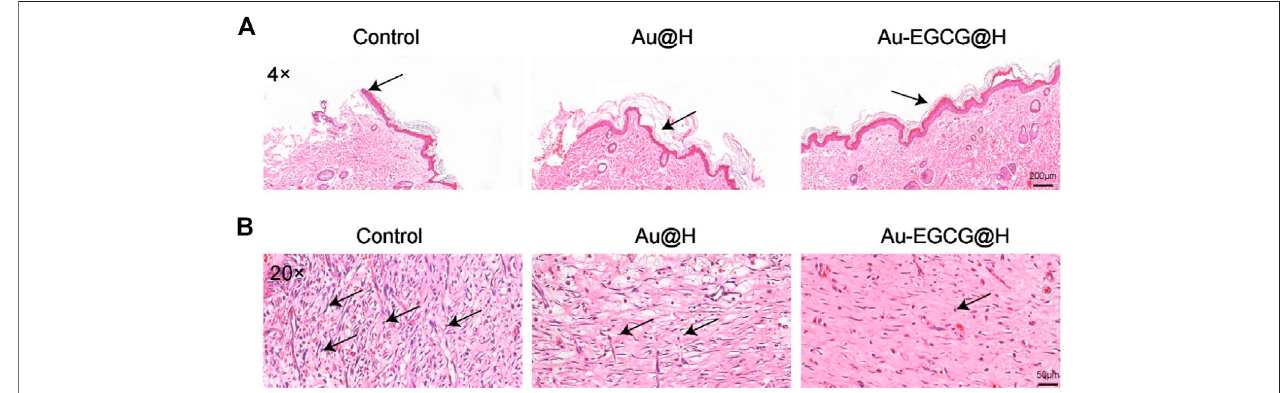
FIGURE 7 | Histological changes at the wound site. (A) The staining of hematoxylin and eosin (H&E) in wound sites after 12 days of distinct treatments, bar (cid:2) 200 μ m. (B) Local enlargement of H&E stain, bar (cid:2) 50 μ m.